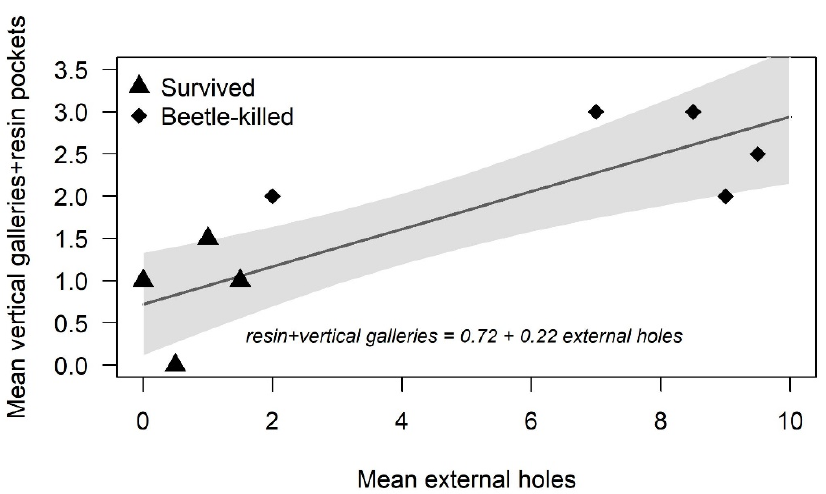
Figure 2. Predicted mean number of vertical galleries (including attempts “resin pockets”) from simple linear regression vs mean number of external holes across tree-level samples with 95% confidence bound in gray. Survived trees (triangles) had fewer holes and galleries than Beetle-Killed trees (diamonds).